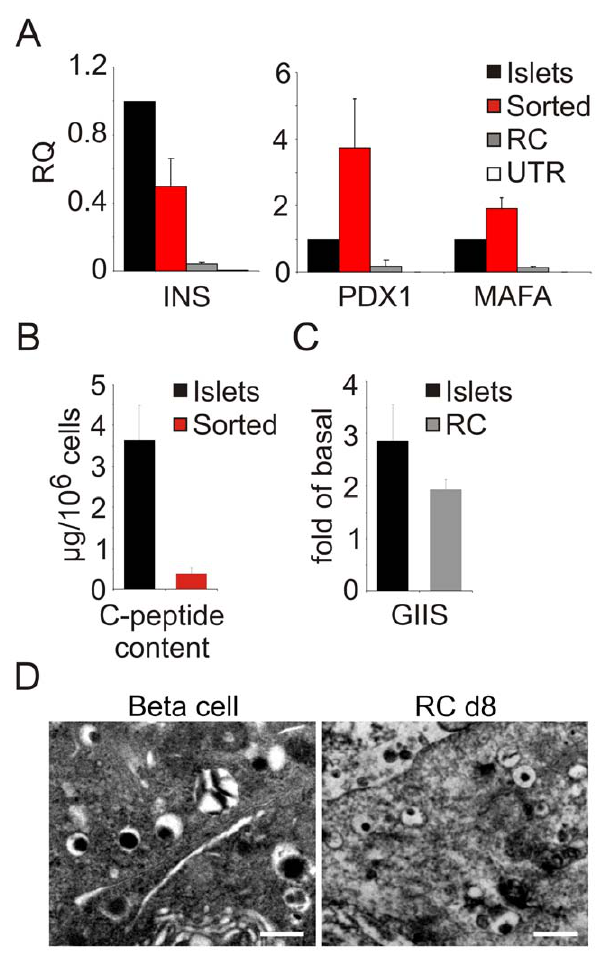
Figure 3. Insulin production and secretion in sorted rediffer- entiated BCD cells. Expanded islet cells (p6–7) were transduced with RIP-DsRed2 vector and treated with RC for 8d. DsRed2 + cells were sorted, and unsorted (RC) and sorted cells were analyzed. A: qPCR analysis of beta-cell transcripts. Values are mean 6 SE, relative to human islets (n=3 donors) and normalized to human RPLPO. B: Human C- peptide content of fresh human islets and DsRed2-sorted RC-treated islet cells. Values are mean 6 SE (n=3 donors). Note that most of the insulin stored is processed (only 9% proinsulin). C: Glucose-induced insulin secretion from human islets and RC-treated expanded islet cells in the presence of 16.7 mM glucose and IBMX. Values are mean 6 SD of human C-peptide, relative to 0 mM glucose and IBMX (n=3 donors). D: Electron microscopic analysis reveals the presence of typical insulin secretory vesicles in cells at p6 treated with RC for 8d, comparable to those seen in beta cells in isolated human islets. Bar=0.5 m m.